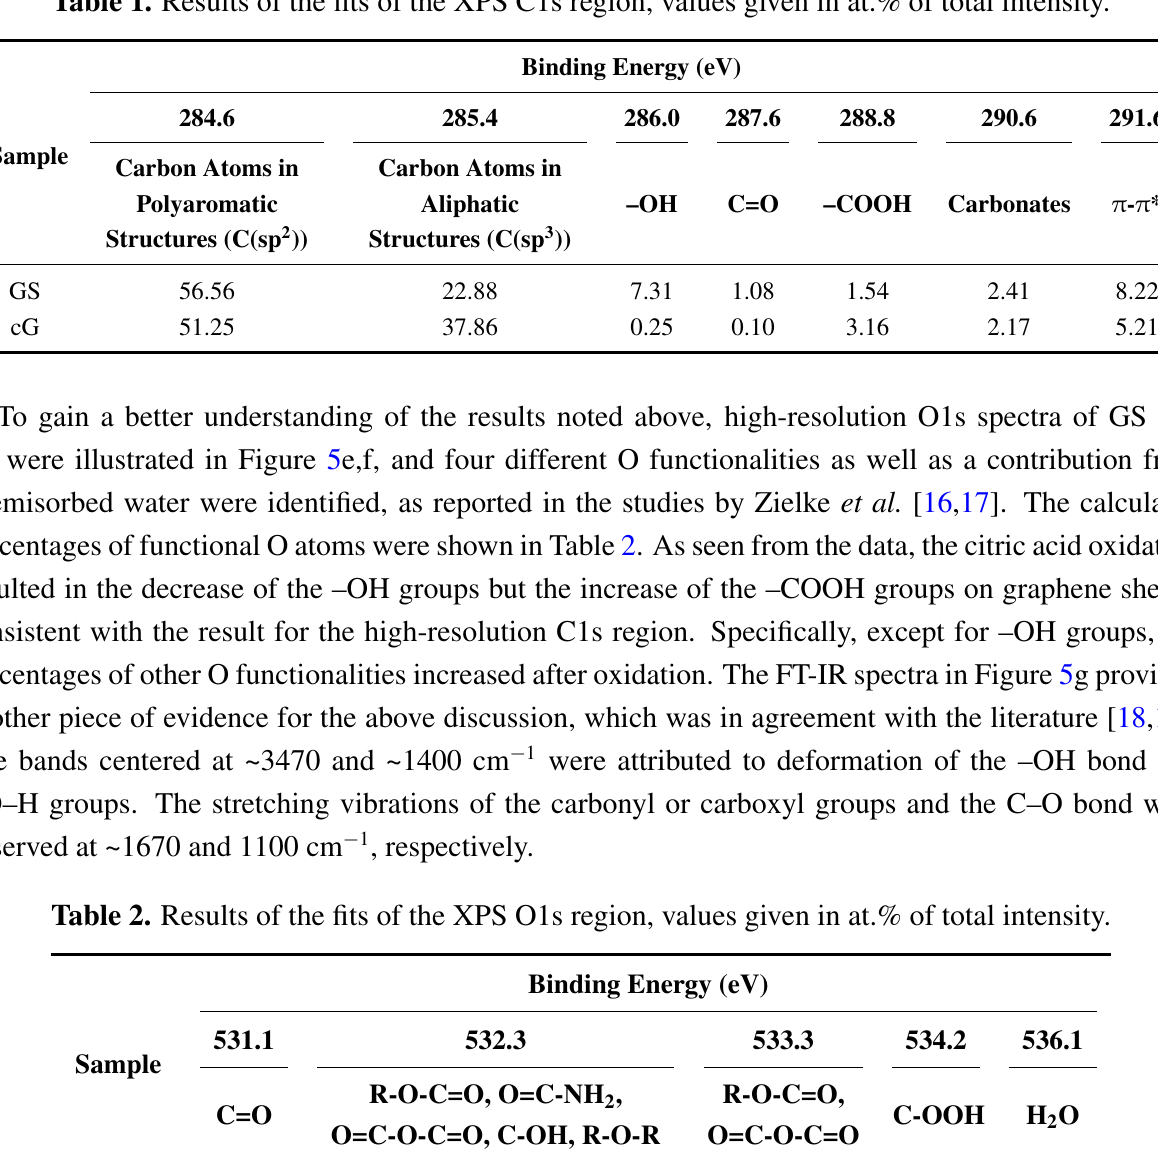
Table 1. Results of the fits of the XPS C1s region, values given in at.% of total intensity. Sample Structures (C(sp 2 ))